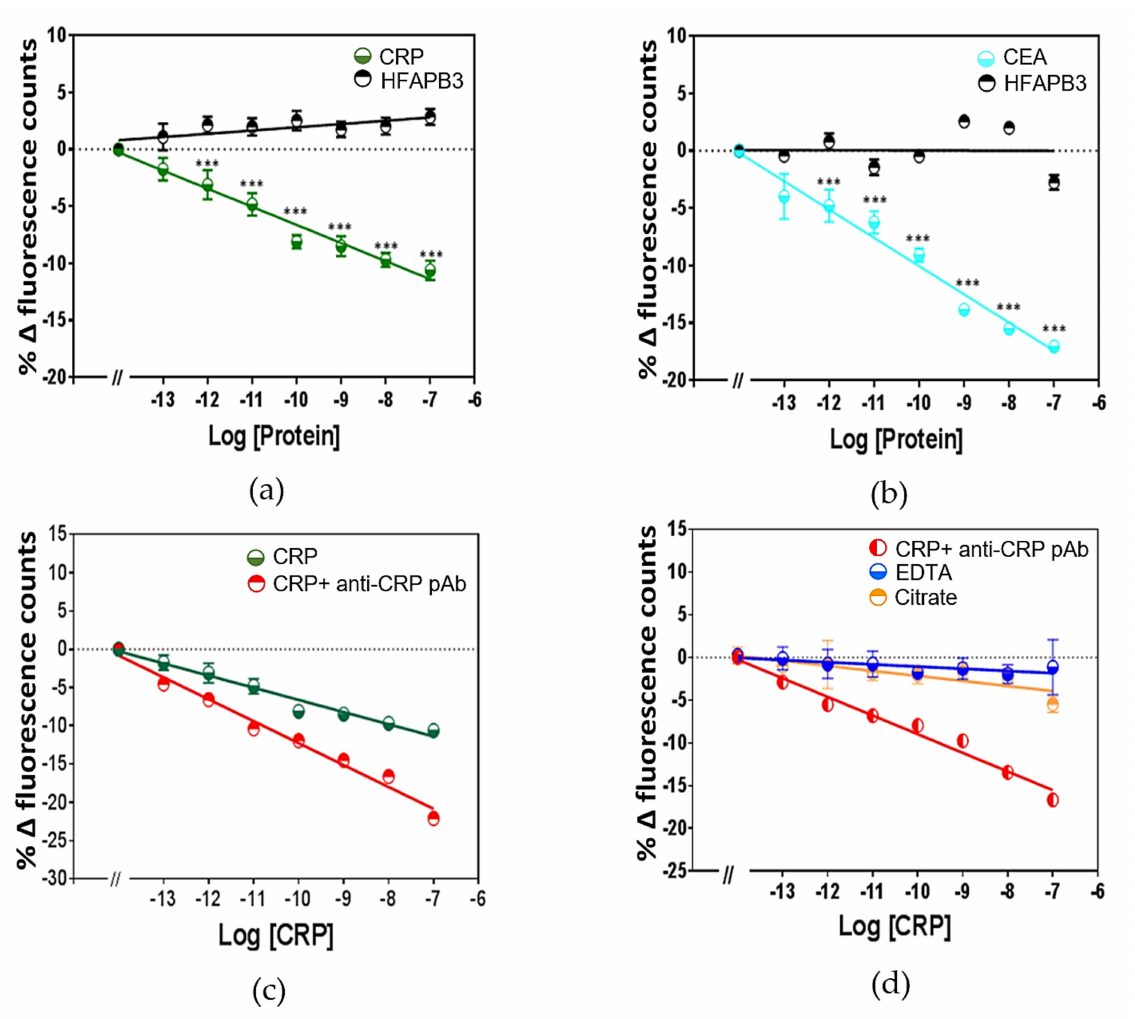
Figure 6. Time-resolved fluorescence counts of Eu 3+ complex in 1% ( v / v ) serum. ( a ), time resolved fluorescence counts of Eu +3 chelated by PMDA modified anti-CRP Affimer; ( b ), time resolved fluorescence counts of Eu +3 chelated by PMDA modified anti-CEA Affimer. HFABP3 were used as a control. ( c ), time resolved fluorescence counts of Eu 3+ complexes quenching against increased concentration of CRP from 100 fM to 100 nM whereas further quenching was observed following the addition of 100 nM polyclonal anti- CRP IgG. ( d ), time resolved fluorescence counts of Eu +3 chelated by PMDA modified anti-CRP Affimer followed adding of 10 µ M EDTA and 1 µ M citrate. Some error bars are smaller than data points (*, ** and *** indicate significance with p -value < 0.05, 0.01, and 0.001 respectively), (Data are means ± SEM (n =